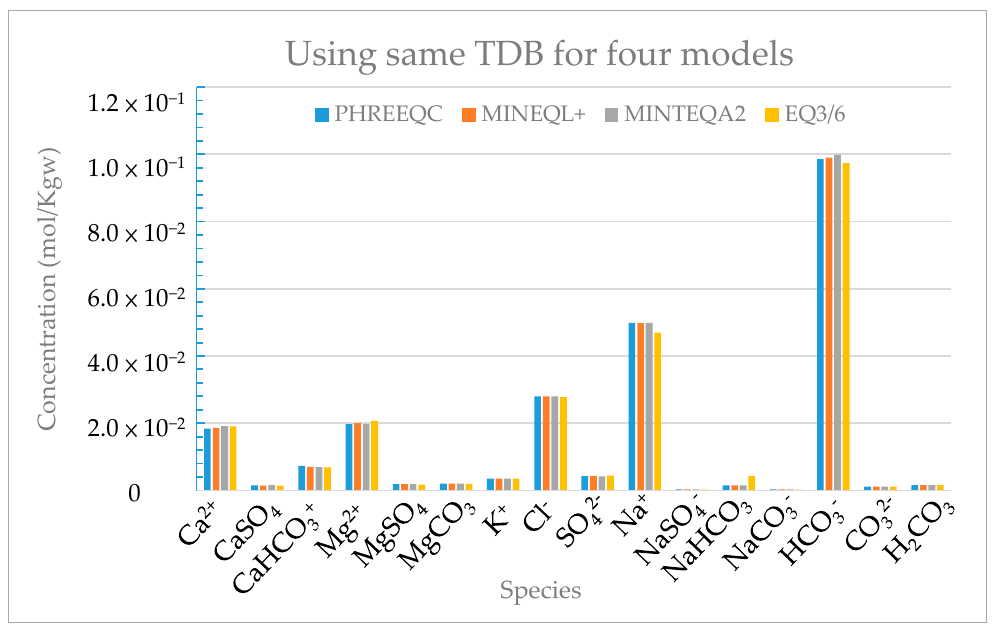
Figure 9. The solution concentration calculated by the Davies equation using the same thermodynamic database of the four models.